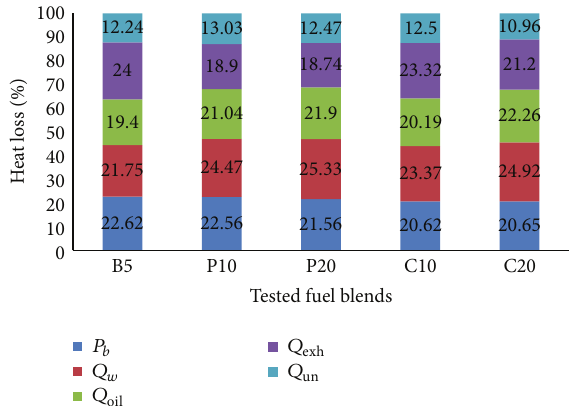
Figure 14: Engine energy balance at 3000 RPM and 100%